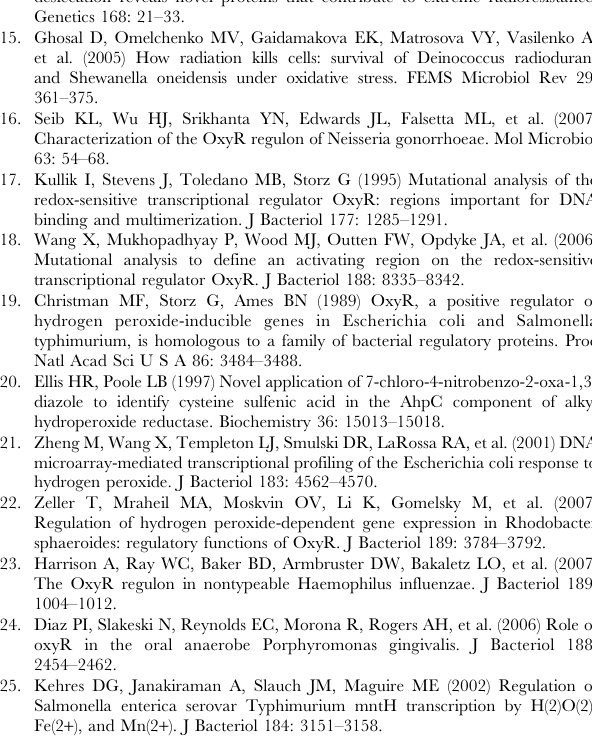
Table S1 The repressed genes showed in MOxyR. All genes are sorted by fold induction or repression.